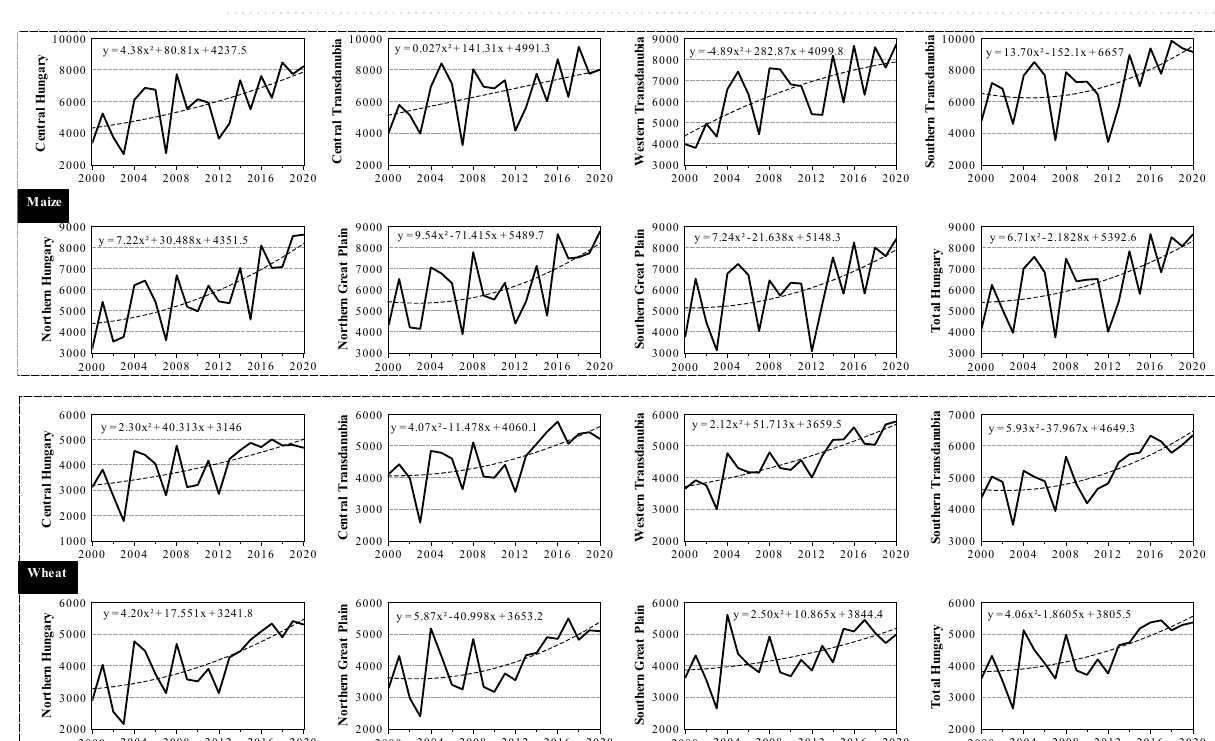
Figure 9. Maize and wheat yields (kg/ha) across Hungarian regions (2000–2020) (figure was generated using EViews (https:// www. eviews. com/ home. was (+ 128.56 kg/ha, p < 0.05) in the Northern Great Plain region, (+ 105 kg/ha, p < 0.05) in the Northern Great Plain and (+ 97.5 kg/ha, p < 0.05) in the Western Transdanubia region. However, to avoid the positive impact of new technology, fertilization and enhanced crop varieties on crop yield, the maize and wheat yield series were detrended before the SYRS was computed. Figure 10 shows the detrended value of SYRS which indicates the changes in the yield of maize and wheat across Hungarian regions, because of climate variability between 2000 and 2020.